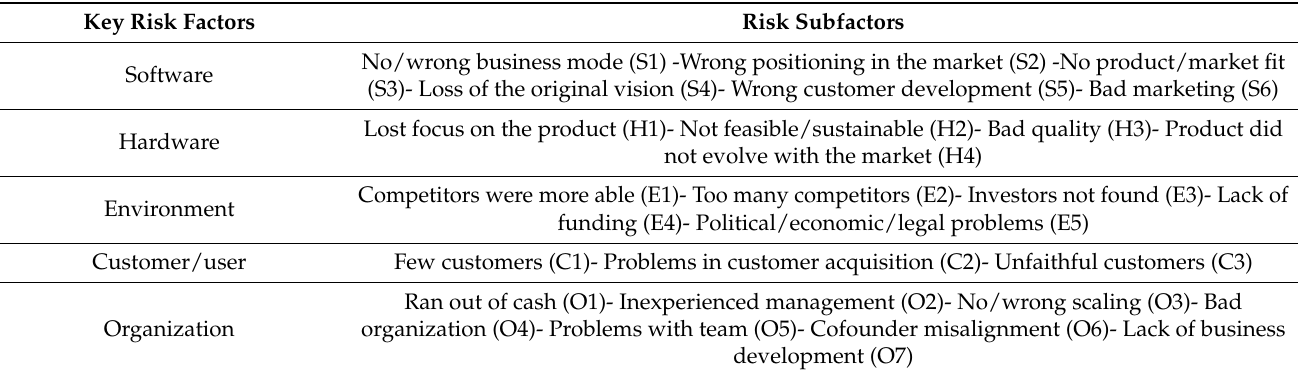
Table 2. Failure factors of start-ups used in the proposed framework (Cantamessa et al.